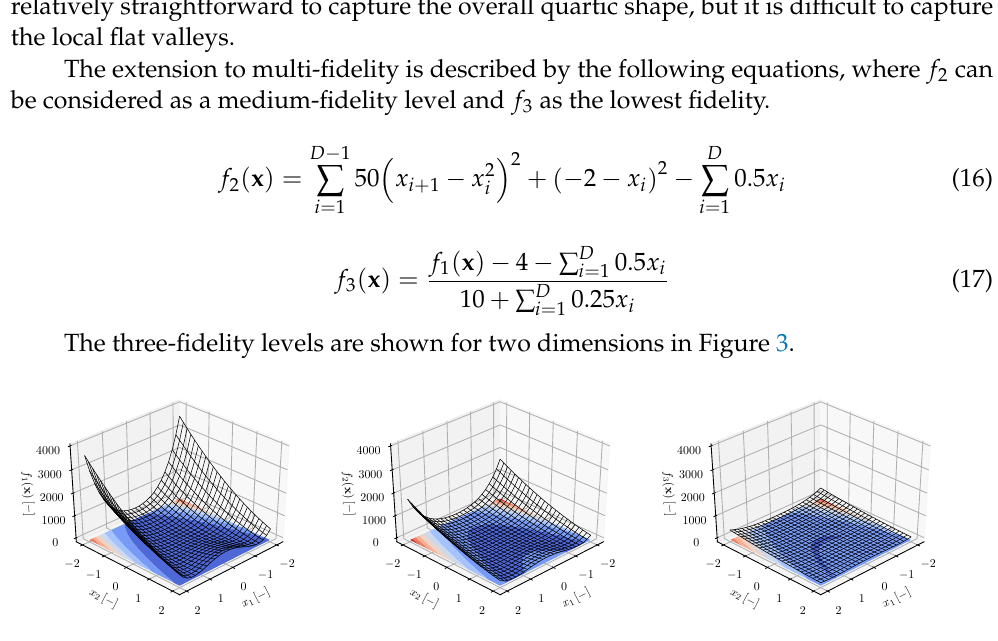
Figure 3. Rosenbrock function (from left to right, high-, medium-, and